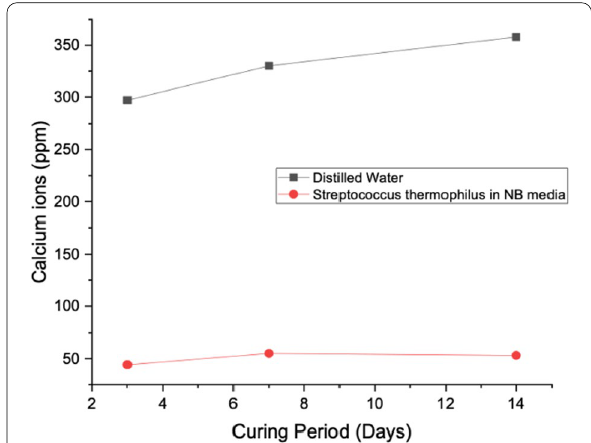
Fig. 5 Calcium ion concentration of distilled water (DW) and